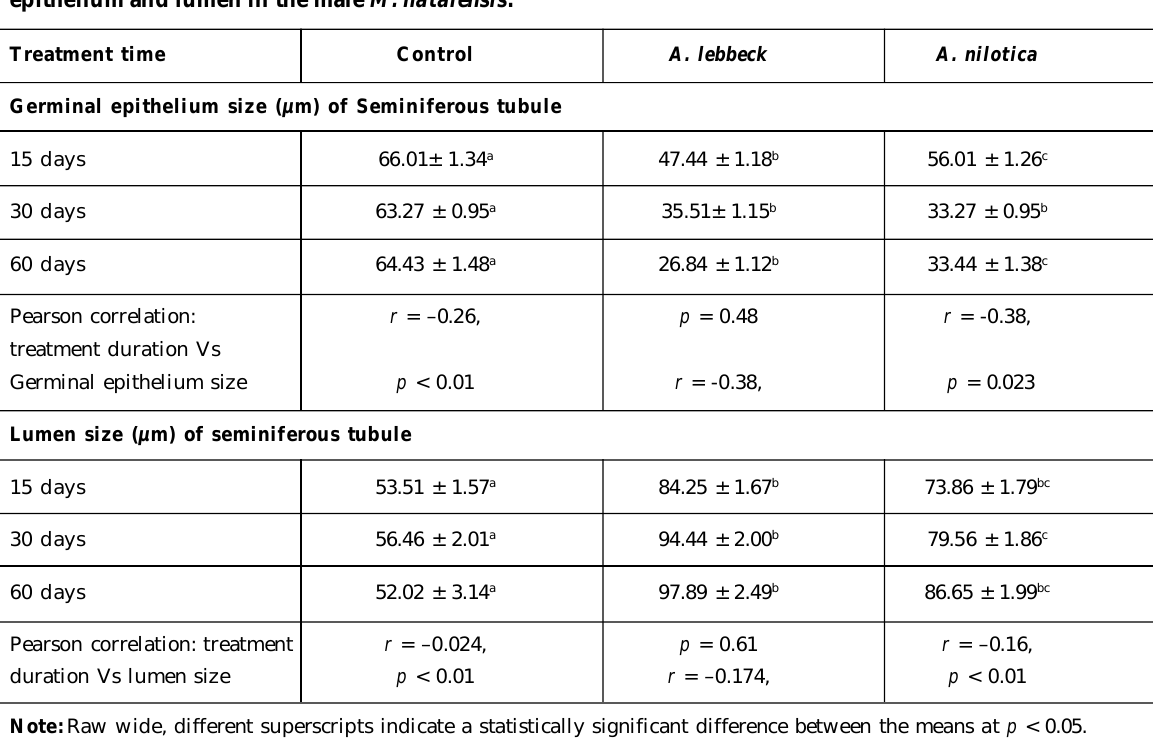
Table 4: Effect of A. lebbeck and A. nilotica extract in feed on the sizes of seminiferous tubule’s germinal epithelium and lumen in the male M. natalensis .